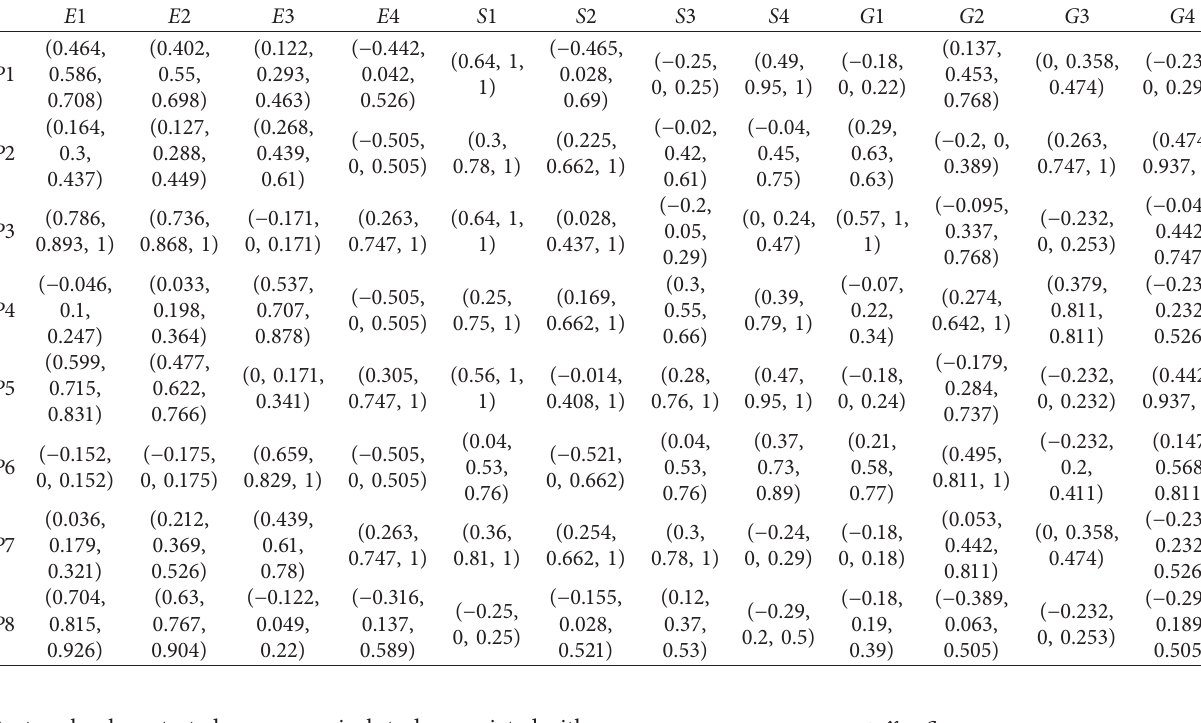
Table 13: Normalized scoring